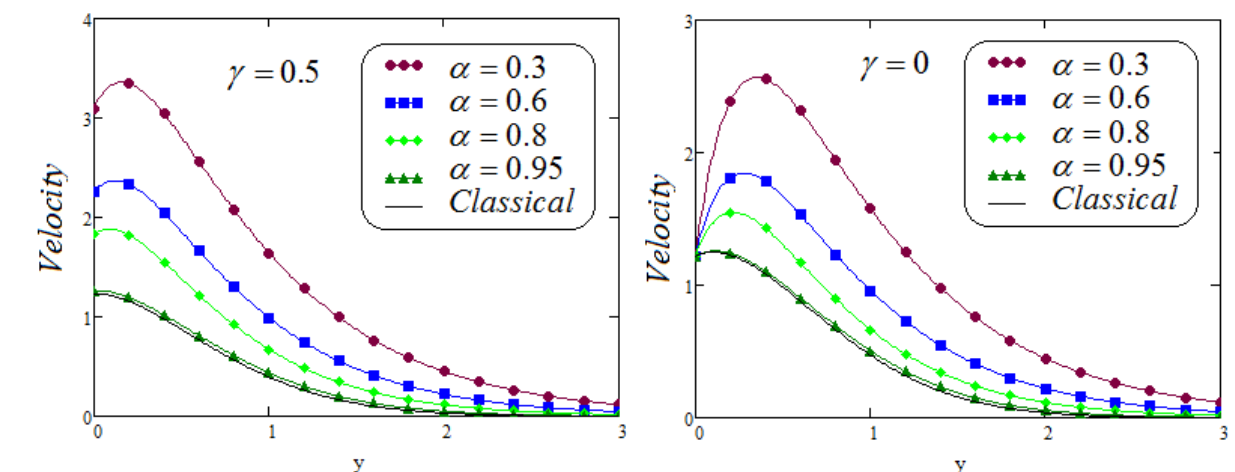
Figure 10. Velocity comparison for varied values of α with and without slip effect γ when f ( t ) = e at , t = 1.5, β = 0.6, Gr = 3.5, λ 1 = 0.6, P r = 0.71, λ 2 = 0.2, M =